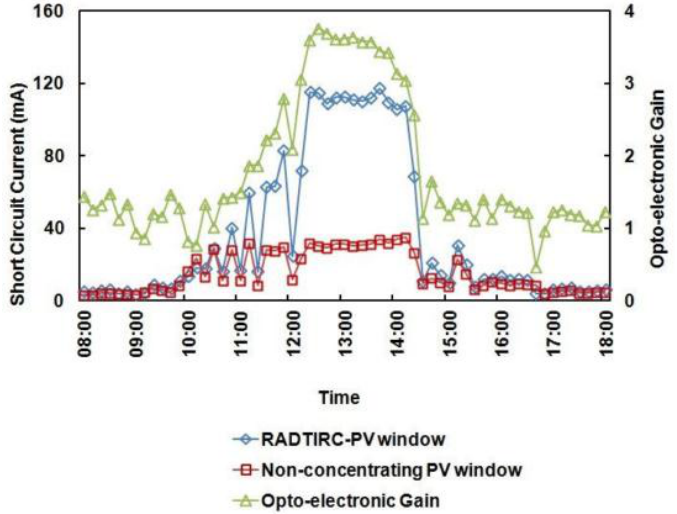
Figure 4. The outdoor experiments in Glasgow, during an almost clear sky day. Adapted from [61].